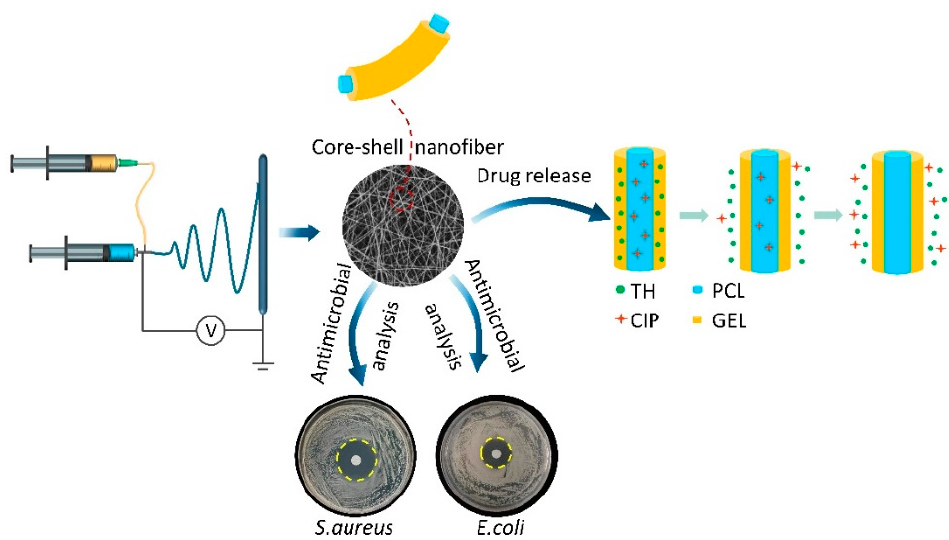
Figure 1. The preparation of coaxial nanofibers with co-delivering of CIP and TH antibiotics.